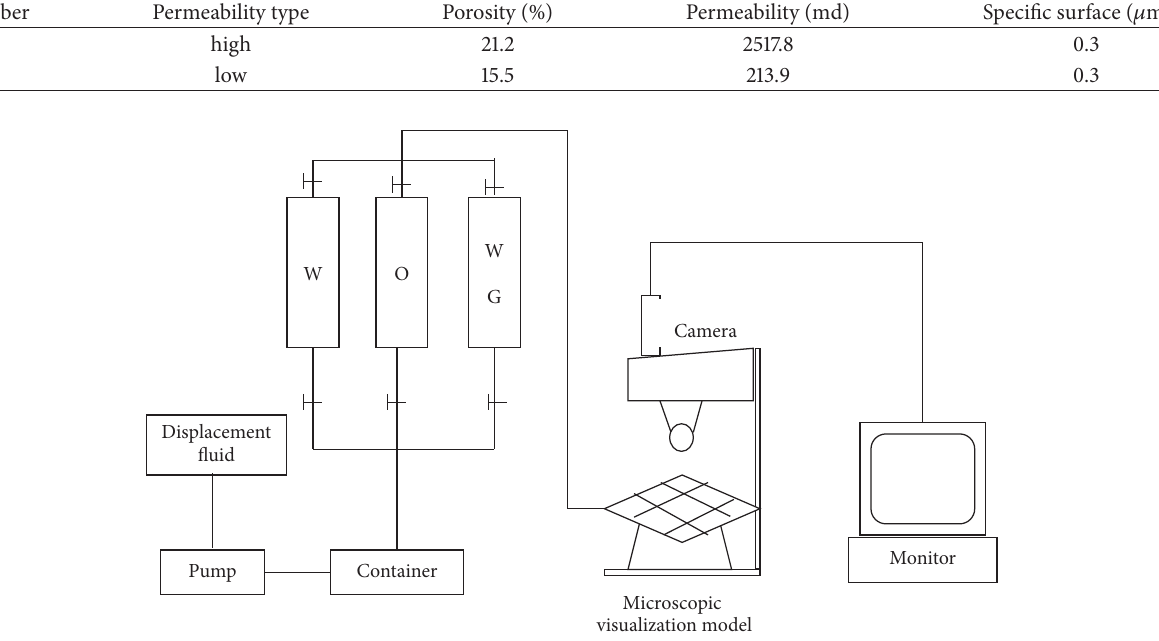
Figure 2: Schematic of microscopic visualization